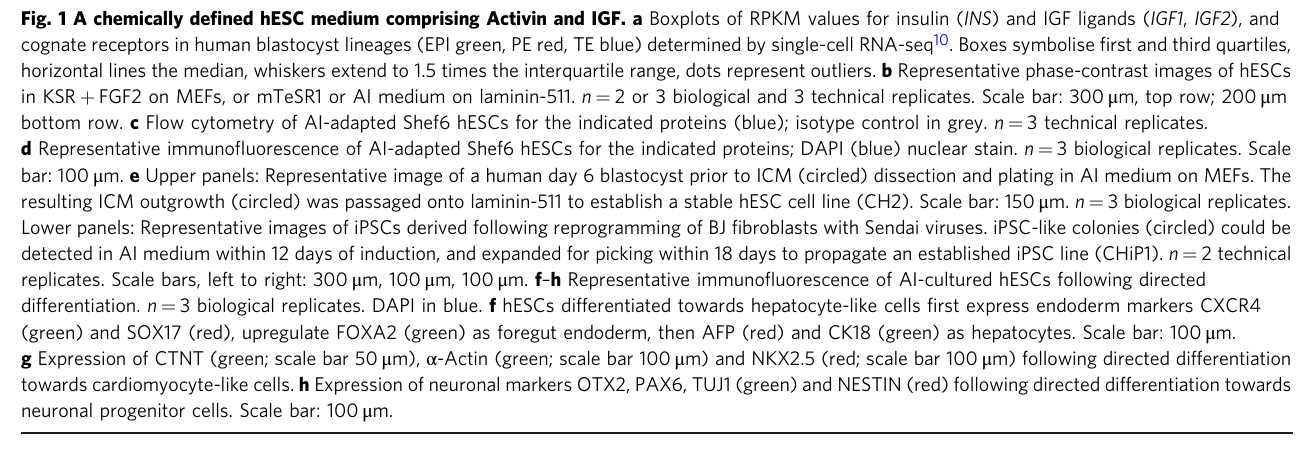
Fig. 1 A chemically de fi ned hESC medium comprising Activin and IGF. a Boxplots of RPKM values for insulin ( INS ) and IGF ligands ( IGF1 , IGF2 ), and cognate receptors in human blastocyst lineages (EPI green, PE red, TE blue) determined by single-cell RNA-seq 10 . Boxes symbolise fi rst and third quartiles, horizontal lines the median, whiskers extend to 1.5 times the interquartile range, dots represent outliers. b Representative phase-contrast images of hESCs in KSR + FGF2 on MEFs, or mTeSR1 or AI medium on laminin-511. n = 2 or 3 biological and 3 technical replicates. Scale bar: 300 μ m, top row; 200 μ m bottom row. c Flow cytometry of AI-adapted Shef6 hESCs for the indicated proteins (blue); isotype control in grey. n = 3 technical replicates. d Representative immuno fl uorescence of AI-adapted Shef6 hESCs for the indicated proteins; DAPI (blue) nuclear stain. n = 3 biological replicates. Scale bar: 100 μ m. e Upper panels: Representative image of a human day 6 blastocyst prior to ICM (circled) dissection and plating in AI medium on MEFs. The resulting ICM outgrowth (circled) was passaged onto laminin-511 to establish a stable hESC cell line (CH2). Scale bar: 150 μ m. n = 3 biological replicates. Lower panels: Representative images of iPSCs derived following reprogramming of BJ fi broblasts with Sendai viruses. iPSC-like colonies (circled) could be detected in AI medium within 12 days of induction, and expanded for picking within 18 days to propagate an established iPSC line (CHiP1). n = 2 technical replicates. Scale bars, left to right: 300 μ m, 100 μ m, 100 μ m. f – h Representative immuno fl uorescence of AI-cultured hESCs following directed differentiation. n = 3 biological replicates. DAPI in blue. f hESCs differentiated towards hepatocyte-like cells fi rst express endoderm markers CXCR4 (green) and SOX17 (red), upregulate FOXA2 (green) as foregut endoderm, then AFP (red) and CK18 (green) as hepatocytes. Scale bar: 100 μ m. g Expression of CTNT (green; scale bar 50 μ m), α -Actin (green; scale bar 100 μ m) and NKX2.5 (red; scale bar 100 μ m) following directed differentiation towards cardiomyocyte-like cells. h Expression of neuronal markers OTX2, PAX6, TUJ1 (green) and NESTIN (red) following directed differentiation towards neuronal progenitor cells. Scale bar: 100 μ